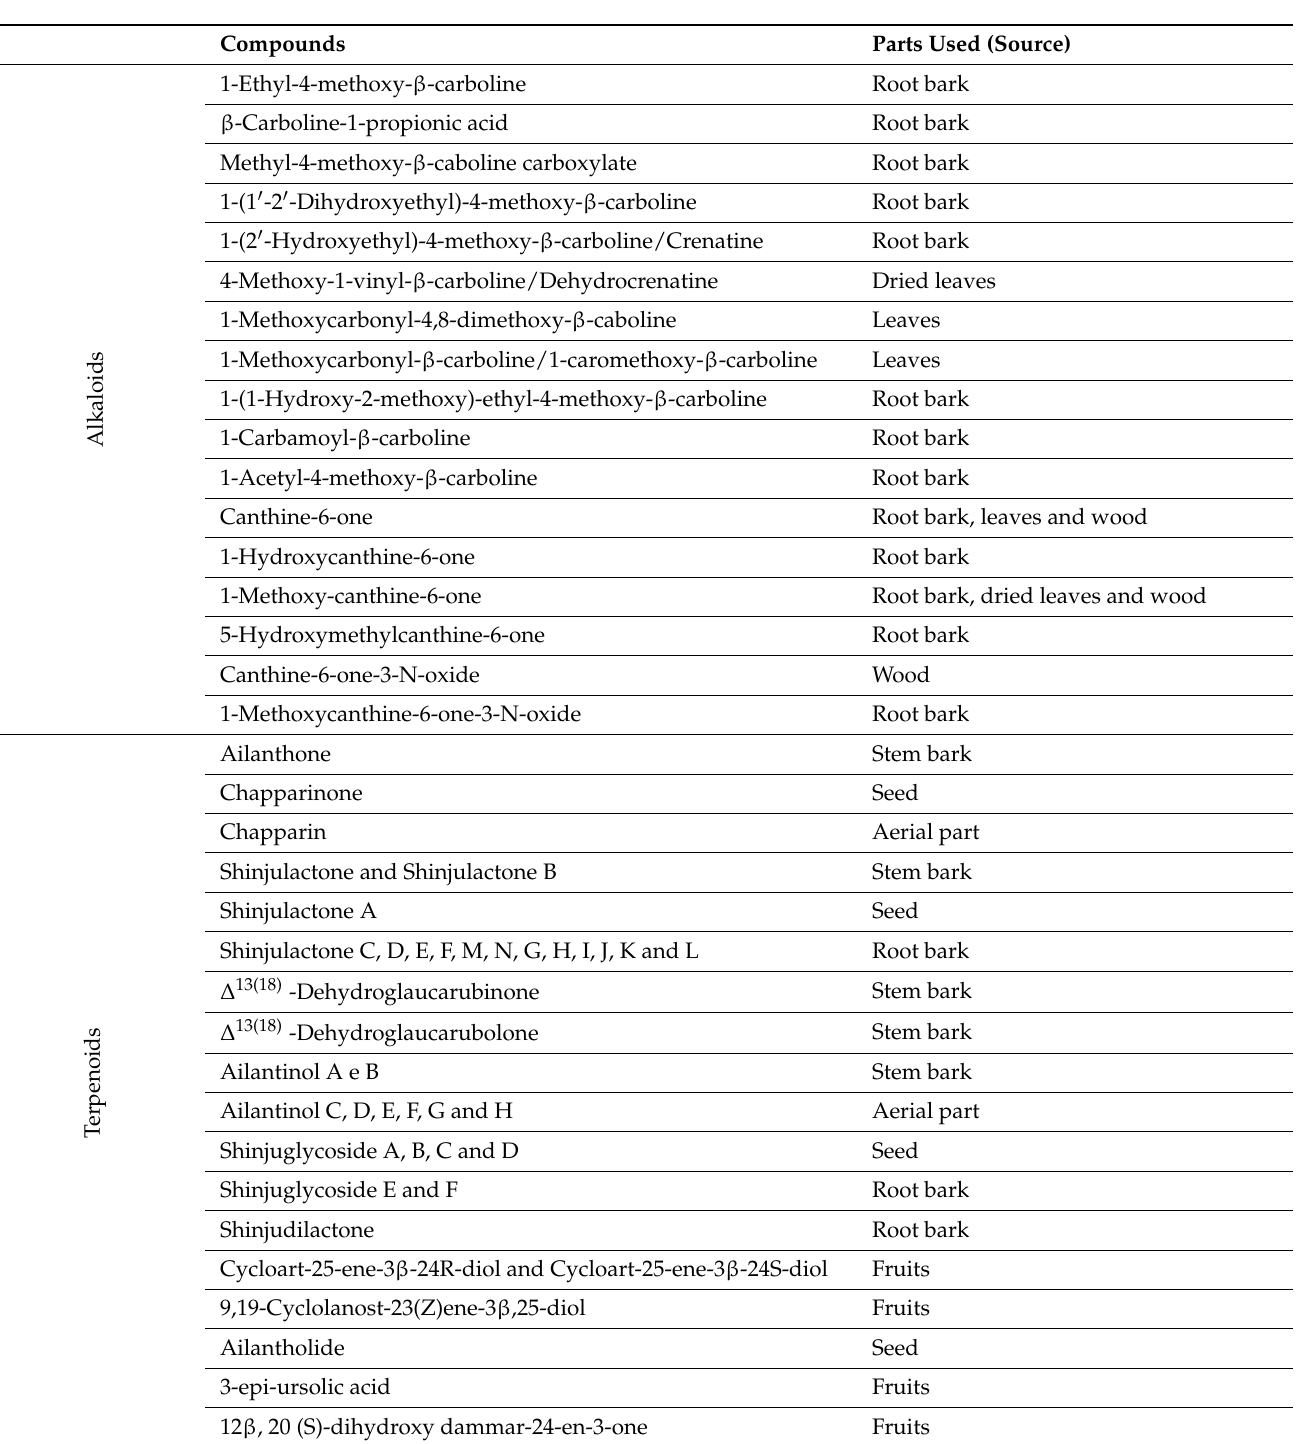
Table 1. The main compounds identified in A. altissima grouped by the major classes and which part of the plant was used for their